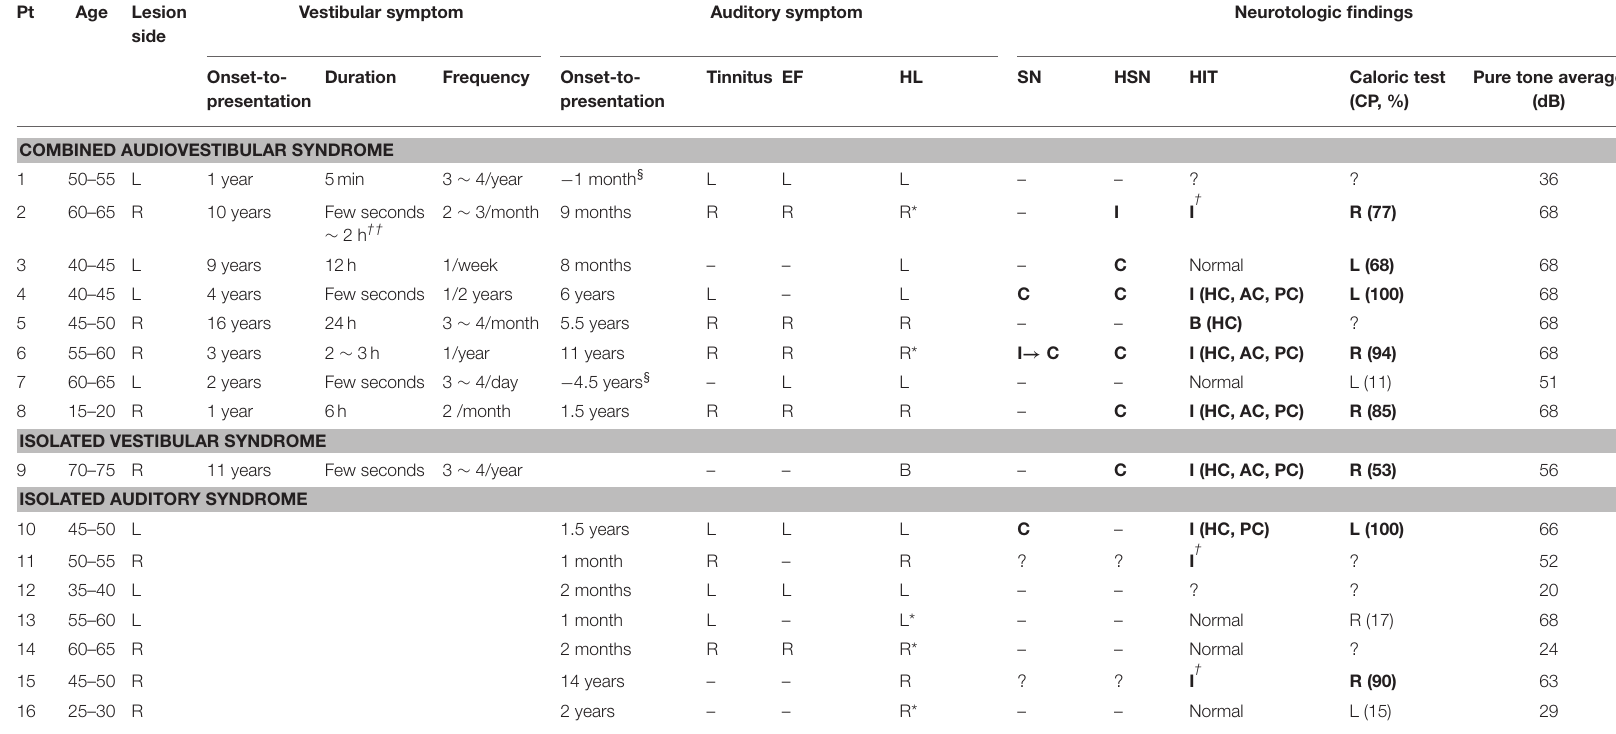
TABLE 1 | Clinical and neurotologic findings in the patients with intralabyrinthine